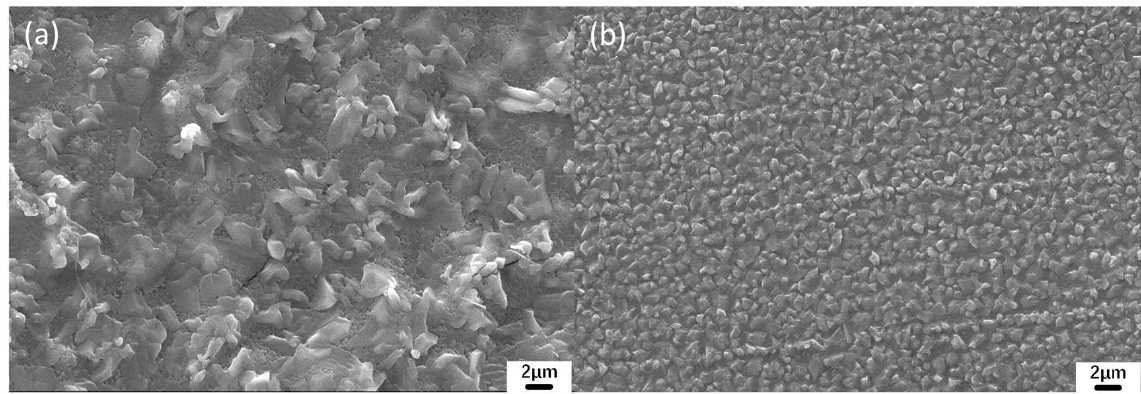
Figure 8. Schematic diagram of the effect of dispersion on resistance.